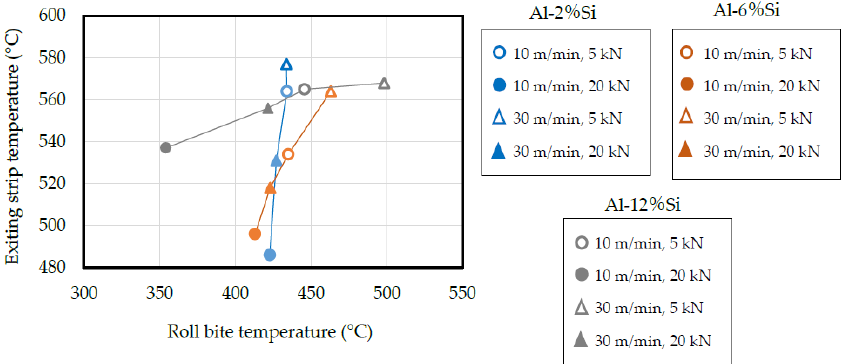
Figure 13. Relationship between roll bite temperature and exiting strip temperature. Roll speed: 10 and 30 m/min; roll load: 5 and 20 kN; Si content: 2%, 6%, and 12%.